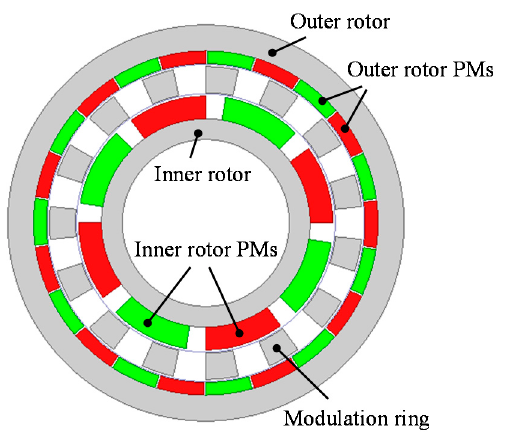
Figure 1. Configuration of the co-axial magnetic gear.